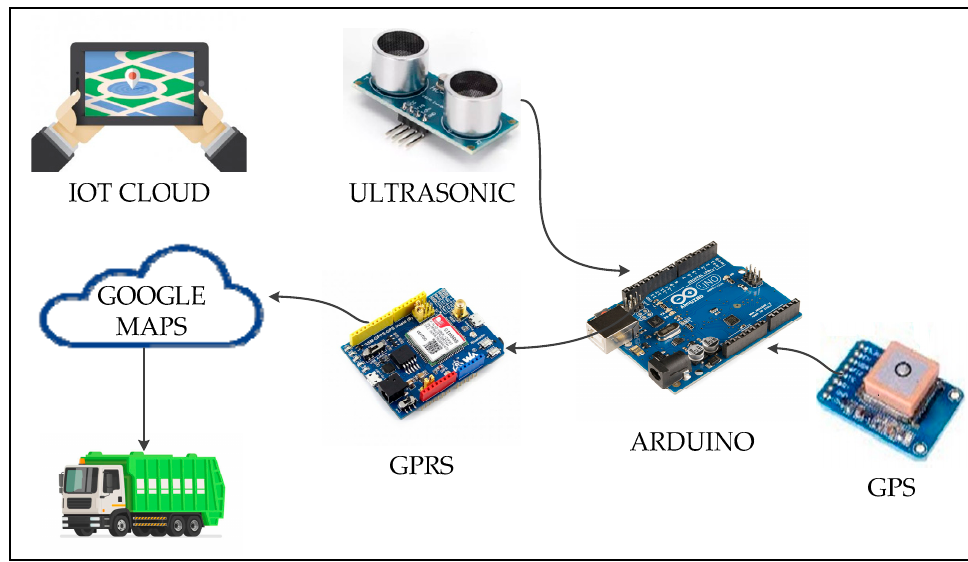
Figure 10. Integrated technology